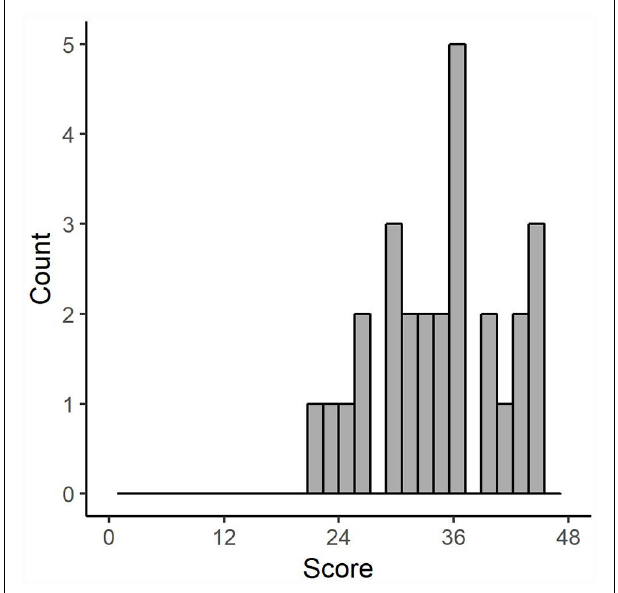
FIGURE 2 | Distribution of conscientiousness scores obtained from our